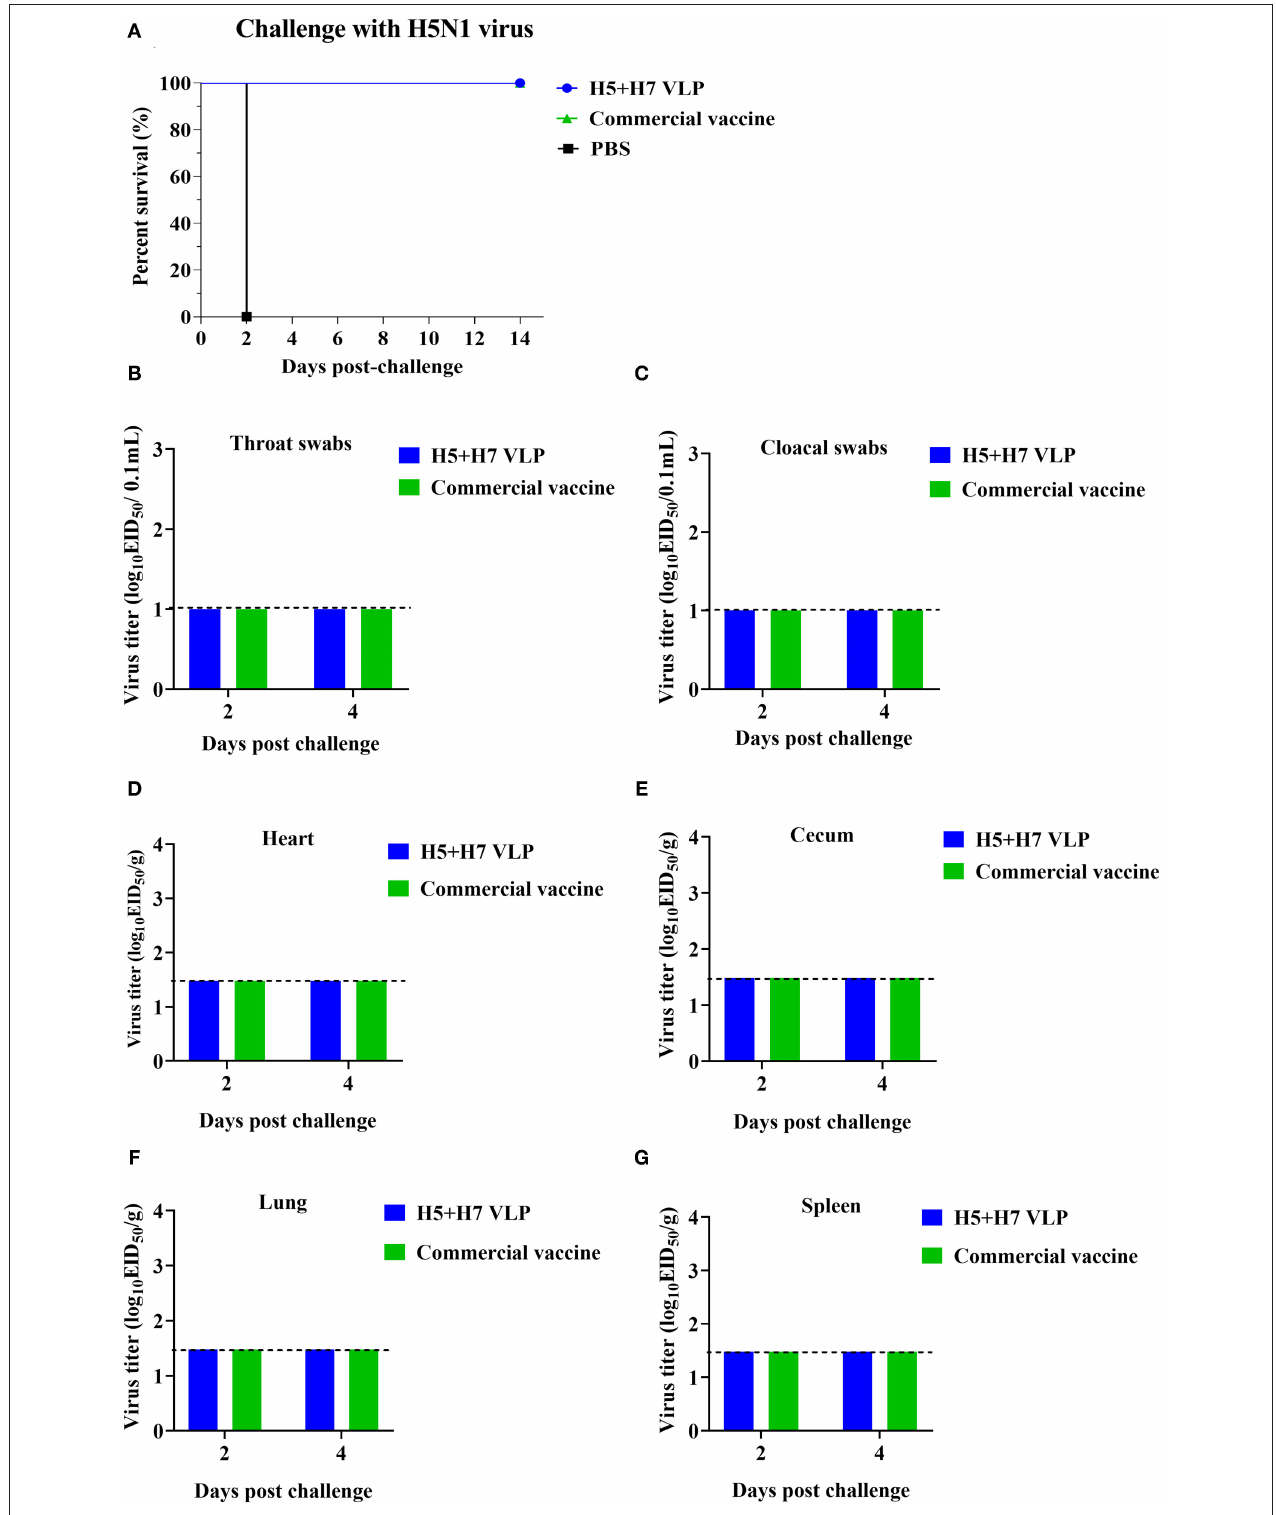
FIGURE 4 | The bivalent H5 + H7 VLP vaccine confers good protection against the lethal H5N1 virus. Chickens were i.m. immunized with 15 µ g of the bivalent H5 + H7 VLP or 0.3mL of the commercial trivalent (H5: Re-11; H5: Re-12; H7: Re-3) vaccine. (A) Survival rates of the birds after challenged with 10 6.0 EID 50 of the H5N1 TT3 virus. (B) Virus titration in laryngotracheal swabs on Day 2 and 4 p.c. (C) Virus titration in cloacal swabs on Day 2 and 4 p.c. Viral titers in the heart (D) , cecum (E) , lung (F) , and spleen (G) of the birds on Day 3 and 5 p.c. Viral titers were determined by measuring EID 50 . The detection limit was below 10 1.0 EID 50 /0.1mL for swabs and 10 1.48 EID 50 /g for